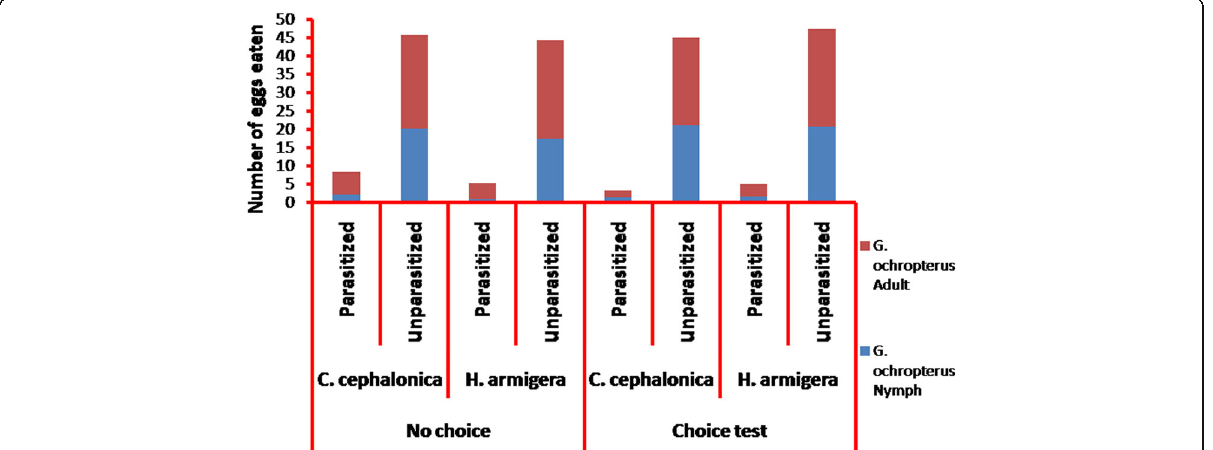
Fig. 1 Total number of parasitized and unparasitized Helicoverpa armigera and Corcyra cephalonica eggs consumed by nymph and adult of Geocoris ochropterus in no-choice and choice